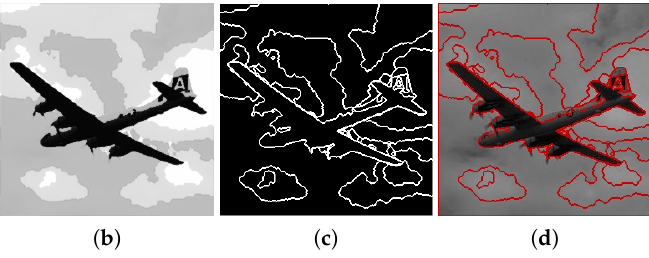
Figure A3. ( a ) Original ‘Plane’ image (from Berkeley Segmentation Data Set 300 [33]), ( b ) ground truth boundary information (also from BSDS300), ( c ) images ( a , b ) overlaid, ( d ) our algorithm output, ( e ) boundaries of the segmented regions, ( f ) boundaries for the segmented regions overlaid on the original image.